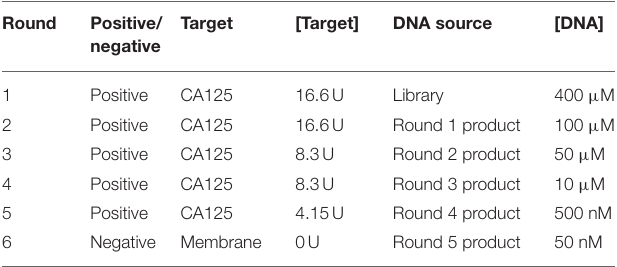
TABLE 1 | Conditions used during different rounds of SELEX. and the last cycle was subtractive to mitigate the non-